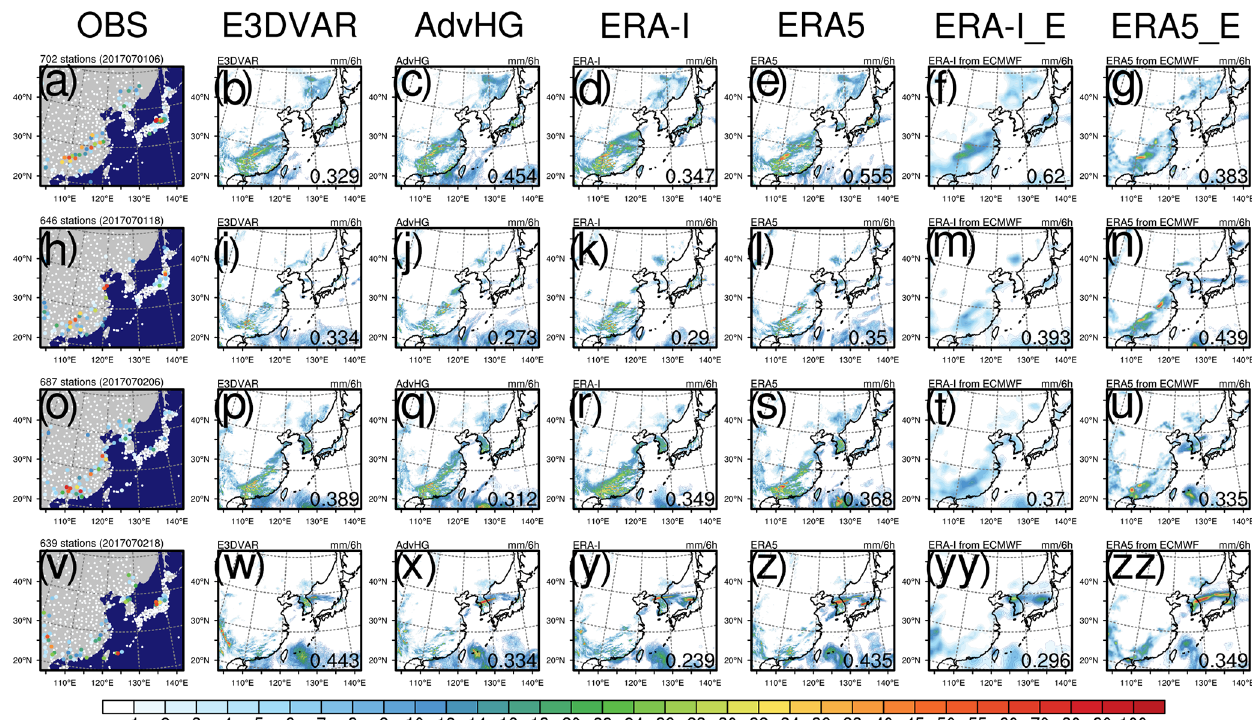
Figure 12. The same spatial distribution of 6h accumulated precipitation as in Fig. 11, but for 1 and 2 July 2017.